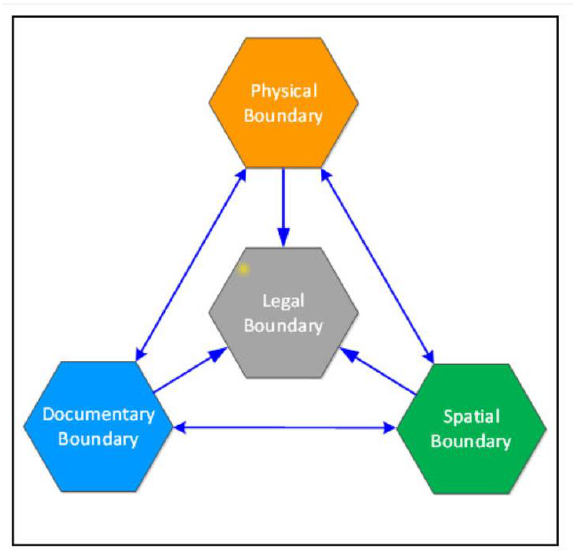
Figure 1 . Elements in a cadastral system (Source: Grant et al. 2018, p.